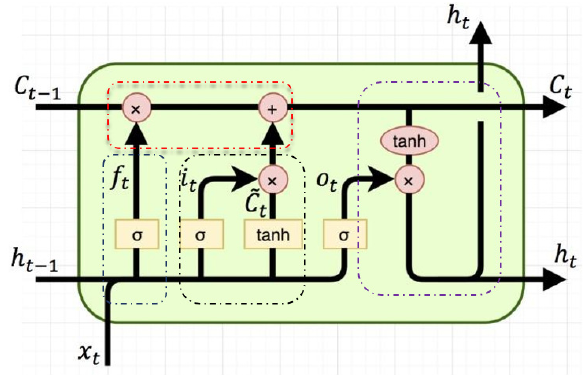
Figure 8. Final calculation diagram of LSTM.